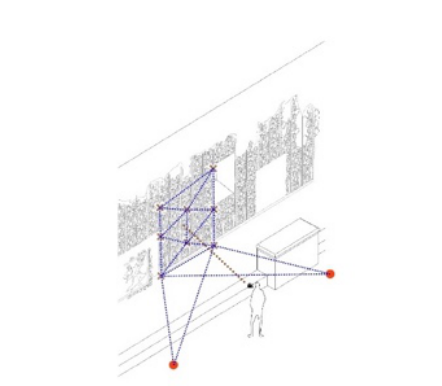
Figure 18 . Scenario 2: Photogrammetric project with REDM Total Station survey. Image by CIMS © GCI 2019.